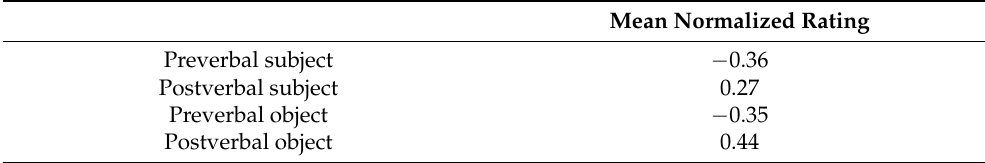
Table 1. Average normalized scores by category and